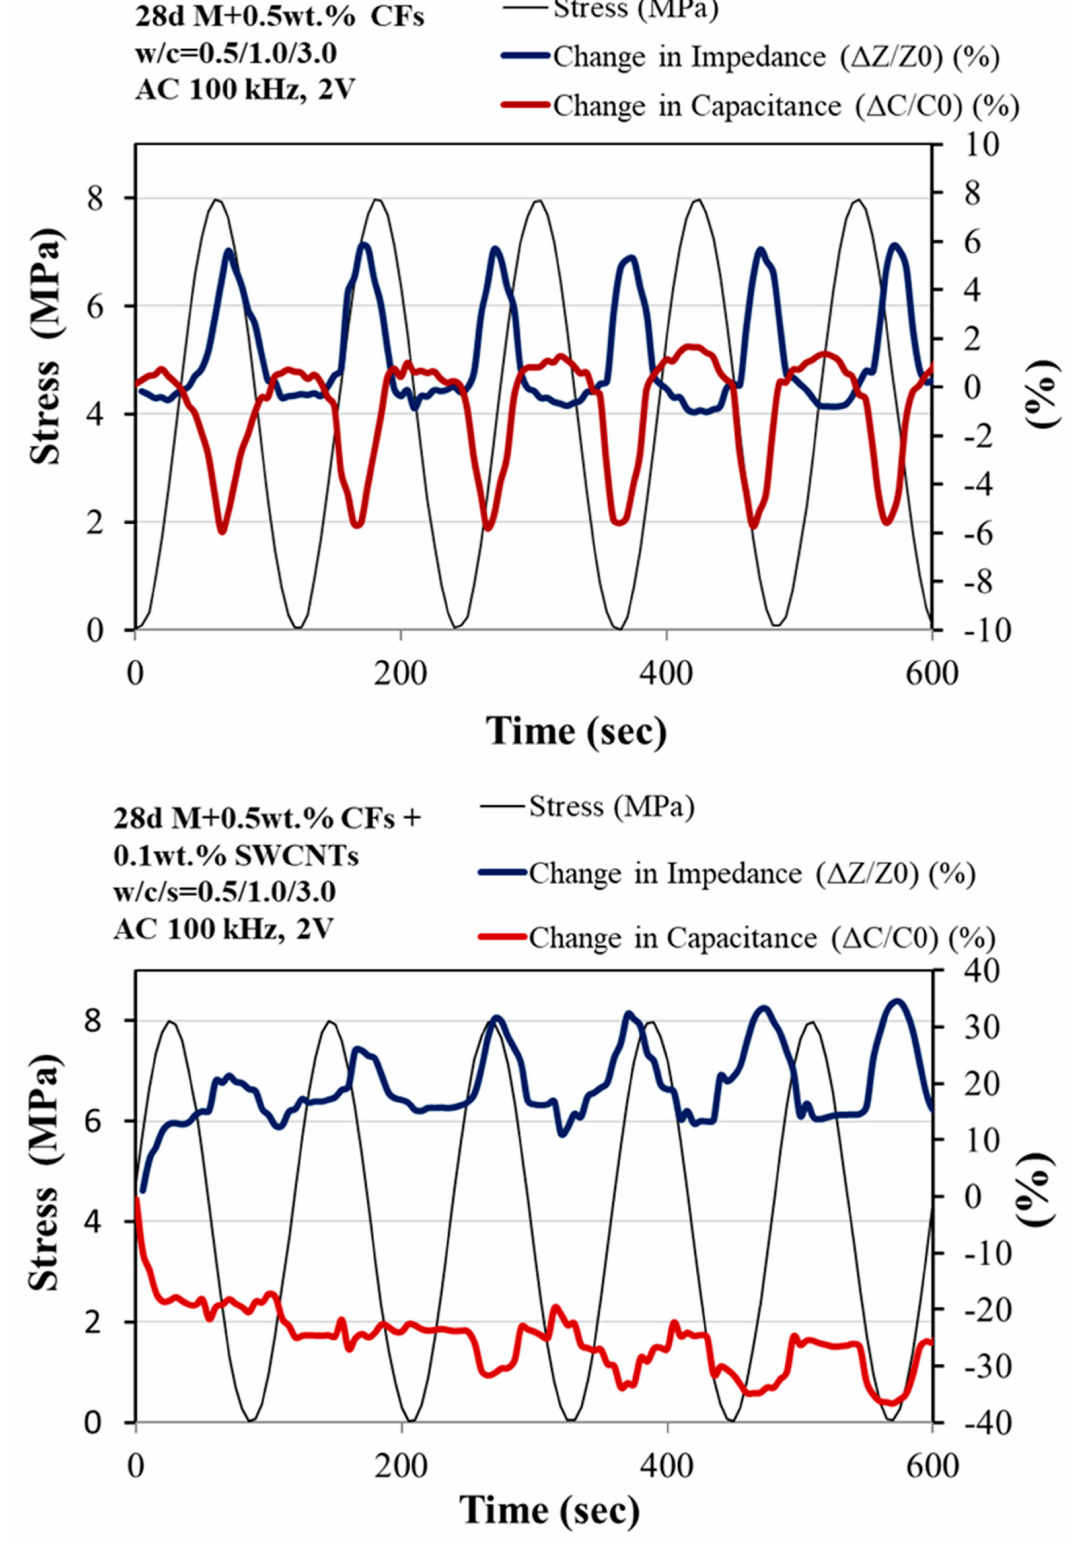
Figure 6. Piezoresistive responses under cyclic loading of 28–d plain, reinforced with 0.1 wt.% SWCNTs, with 0.5 wt.% CFs, and hybrid-modified